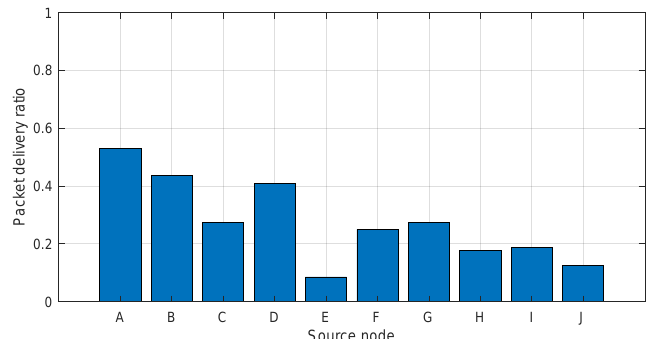
Figure 27. End-to-end packet delivery ratio from the North Sea deployment. It shows the overall poor performance for many nodes due to excessive link